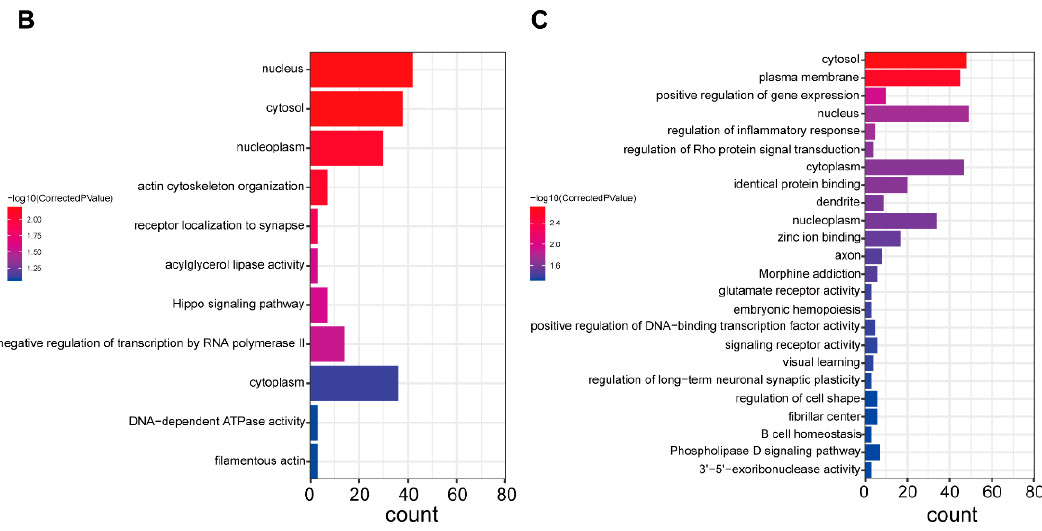
Figure 3. Identification of the local segments in which proportions of a certain ancestry were signif- icantly higher than the proportion in the whole genome in Dehong humped cattle. ( A ) Distribution of the local segments whose proportions of Chinese indicine and Indian indicine were excessive compared with the average level of the whole genome. ( B ) The KEGG pathways and gene ontology from the enrichment analyses of genes with excessive Chinese indicine proportions. ( C ) The KEGG pathways and gene ontology from the enrichment analyses of genes with excessive Indian indicine proportions.